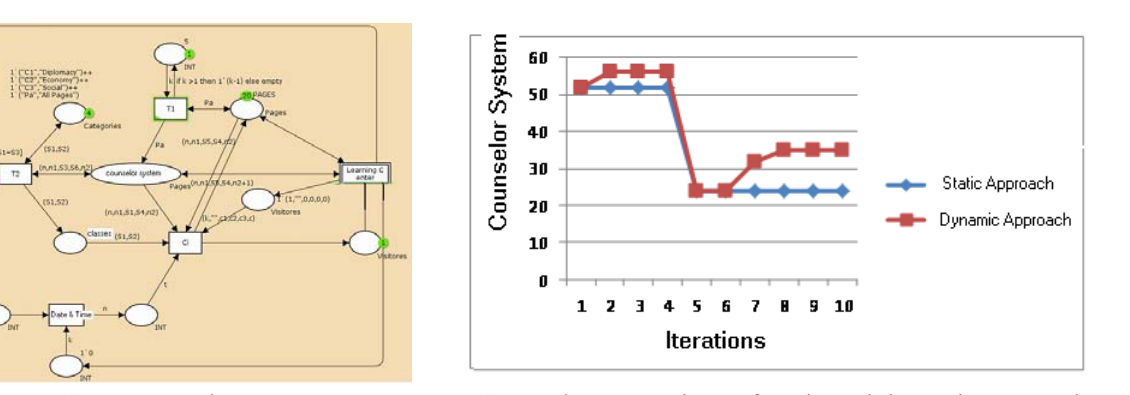
Fig. 1. counselor system Fig. 2. The comparison of static and dynamic